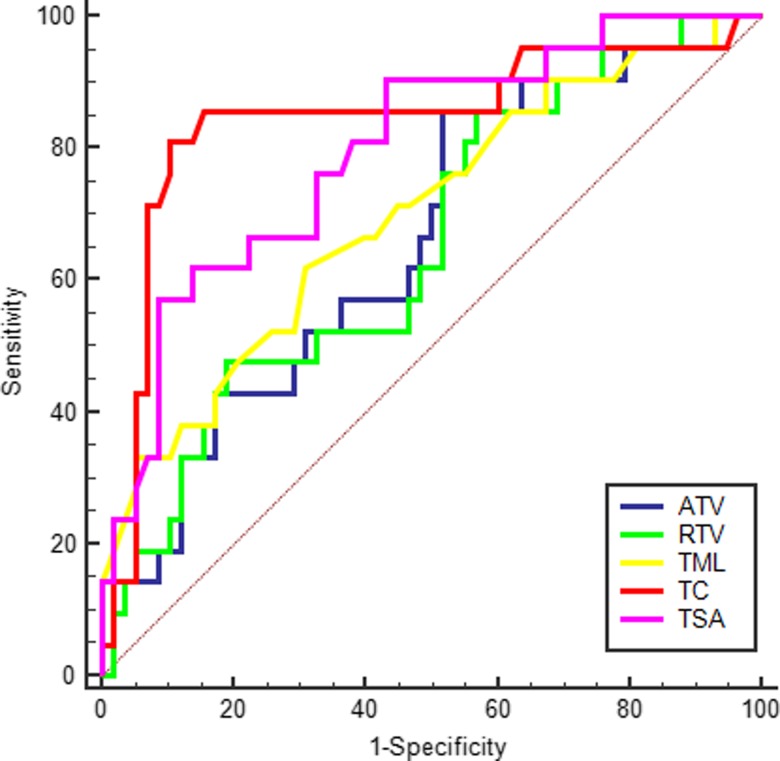
ROC curve of ATV, RTV, TML, TC and TSA using the pCR as test variable in the non-mucinous adenocarcinoma subgroup.